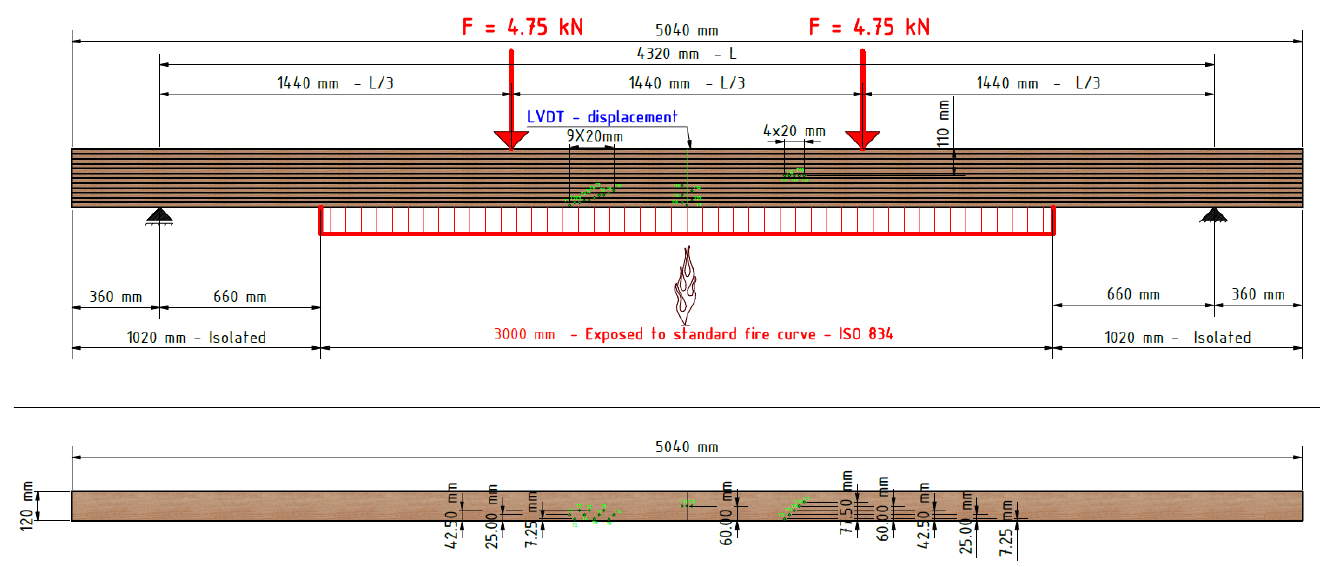
Figure 9. Fire test–experiment setup.